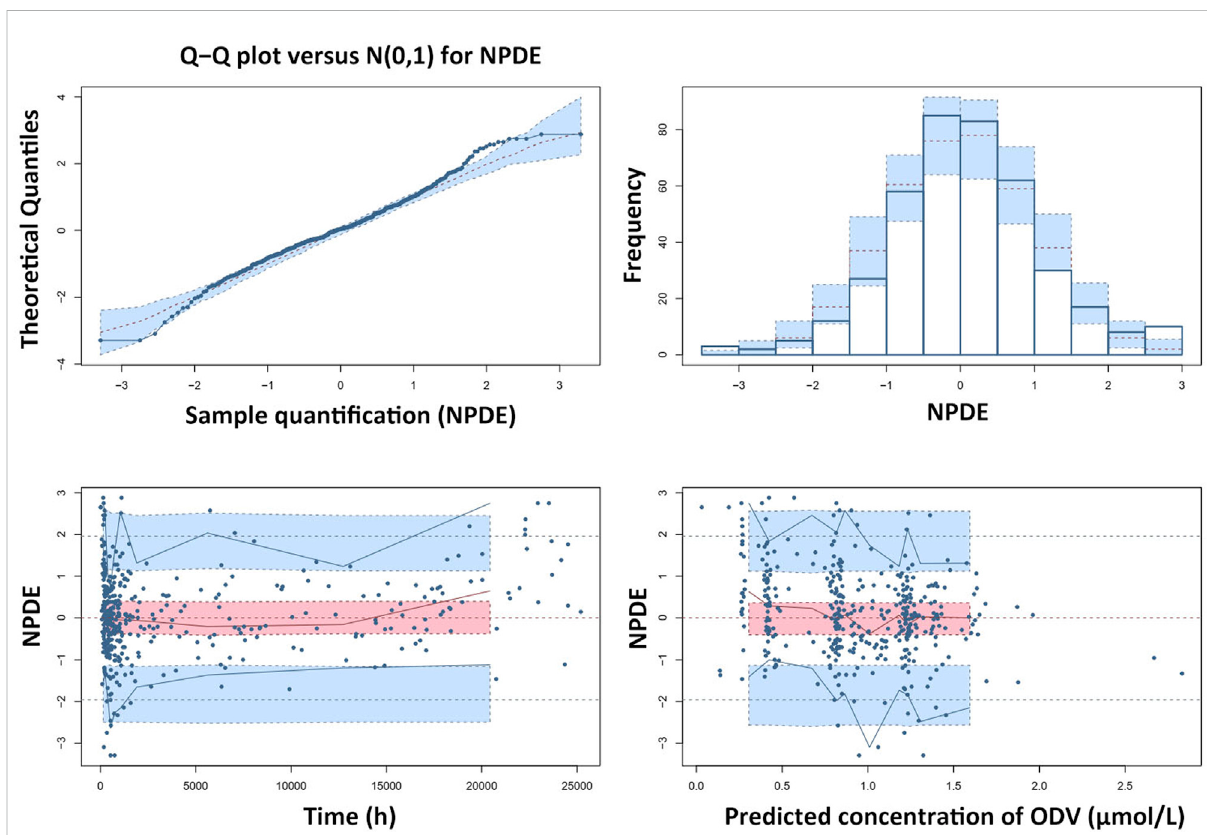
FIGURE 7 Results of the NPDE analysis for ODV. The left upper plot is a QQ-plot for NPDE; the right upper plot is a histogram of the NPDE; the left lower and right lower plots represent the NPDE versus time and the NPDE versus the predicted concentrations of ODV,